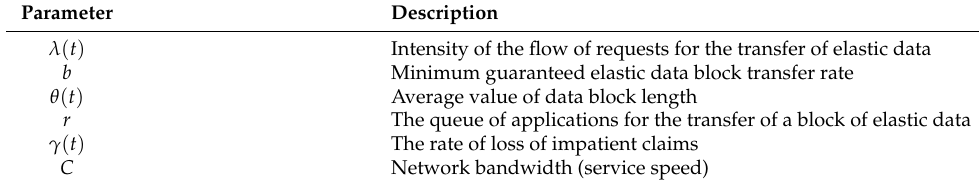
Table 1. System model